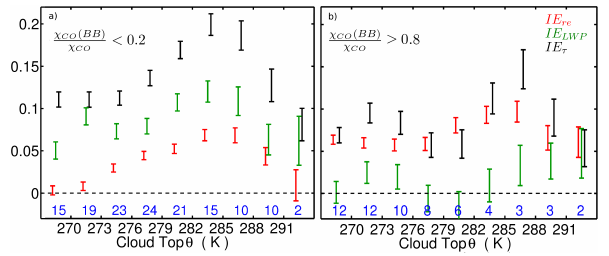
Fig. 8. As for Figure 6 except the plots represent IE values plotted within 3 K bins in potential temperature for Arctic clouds coincident with biomass burning χ CO concentrations that are either (a) > 80% or (b) < 20% of the total χ CO concentrations.